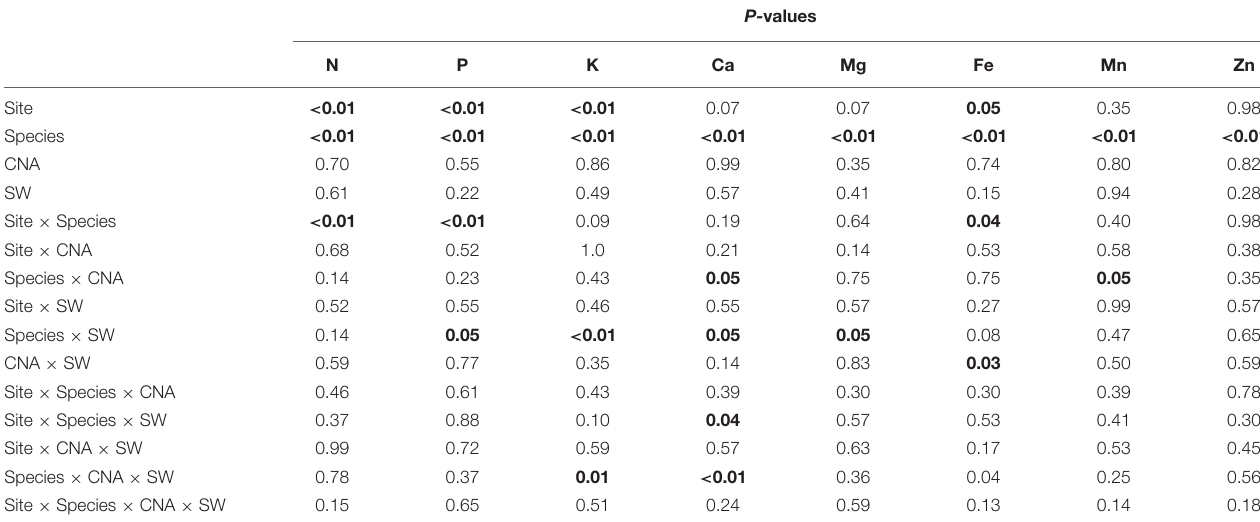
TABLE 3 | Result of the mixed model analysis conducted on seedlings’ foliar chemistry with site, species, canopy N addition (CNA) and soil warming (SW) as fixed effects and blocks as random effect.